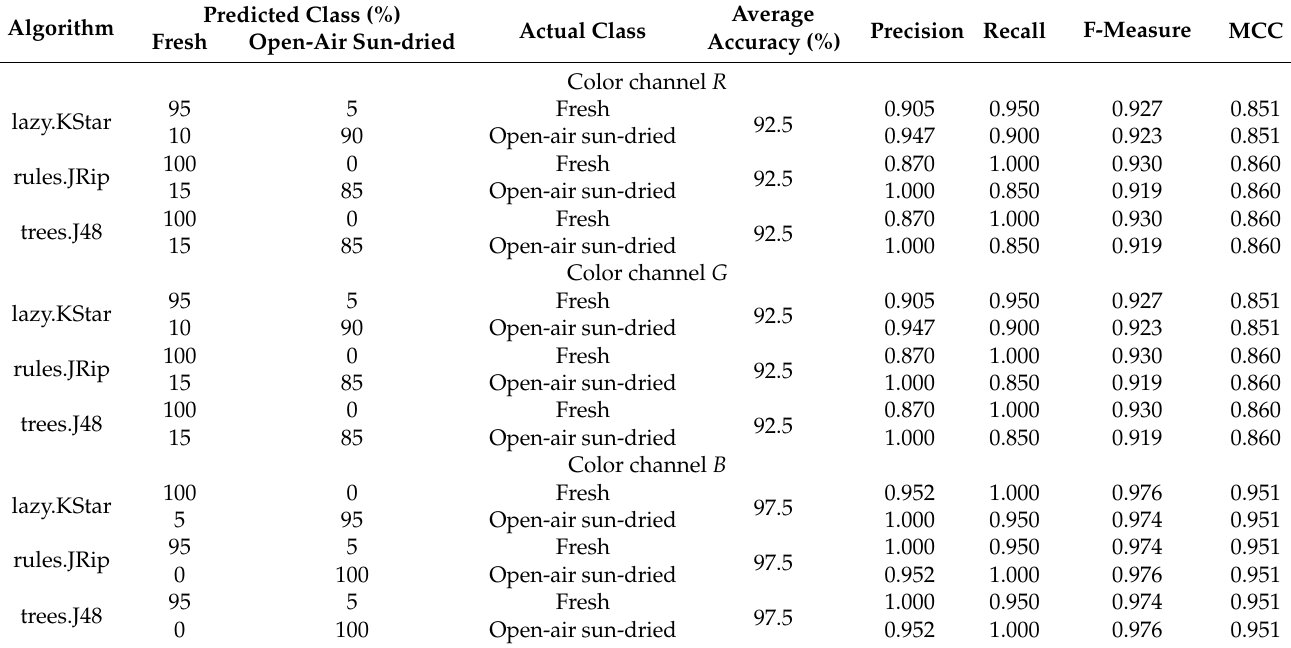
Table 10. The differentiation of fresh and open-air sun-dried mint leaves in terms of selected image textures of the dorsal leaf side based on models built for color channels R , G , and B from color space RGB.